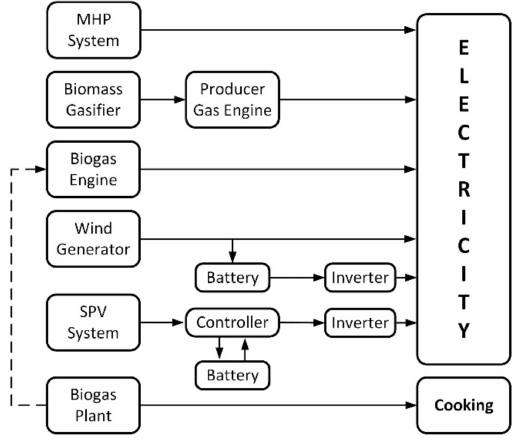
Figure 6. Configuration of the integrated renewable energy optimization model (IREOM). Reproduced with permission from [37], [Renewable Energy], published by [Elsevier],